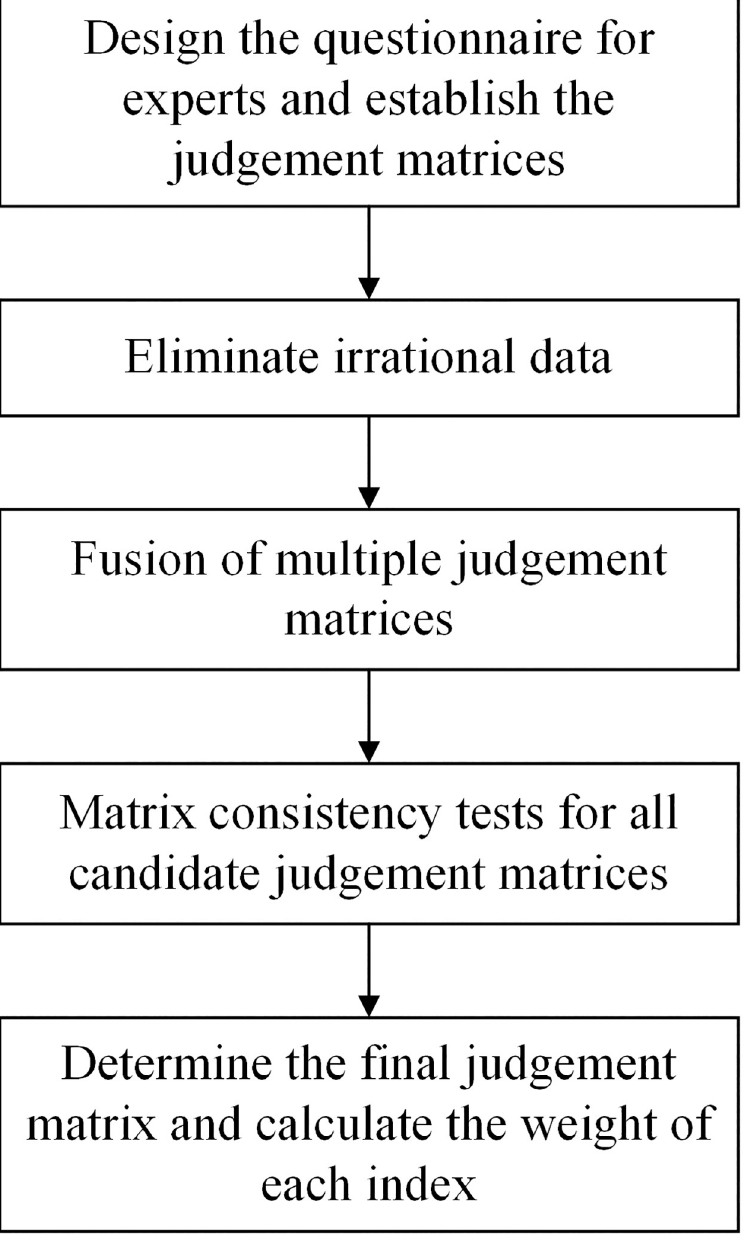
Fig 2. The roadmap of the improved AHP